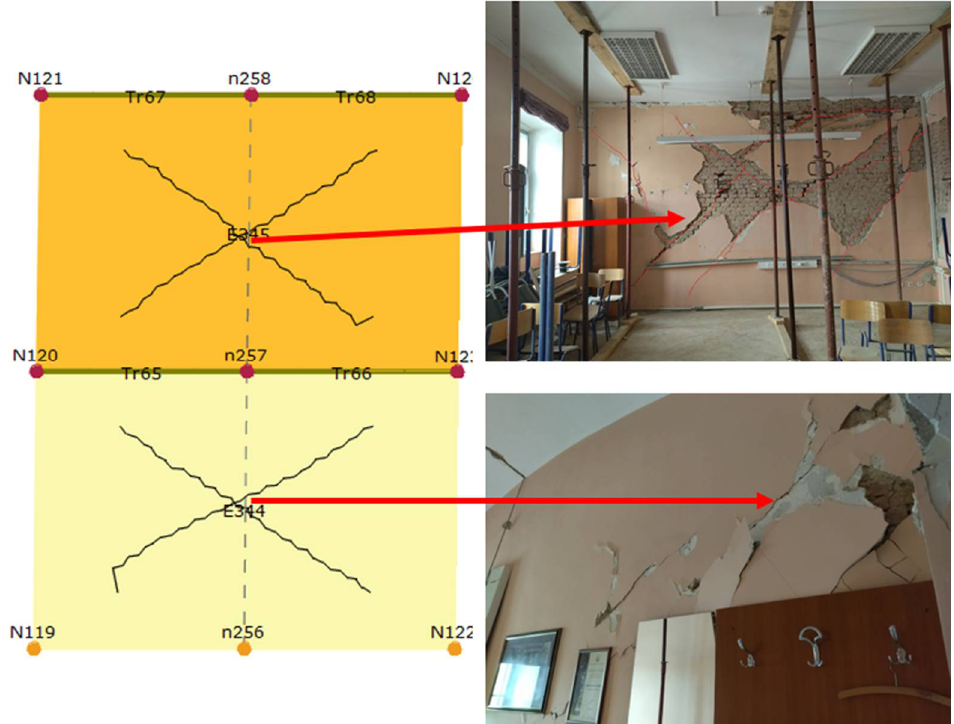
Figure 17. Detailed display of damage in the 3Muri software package and actual damage to the walls of the building in question.